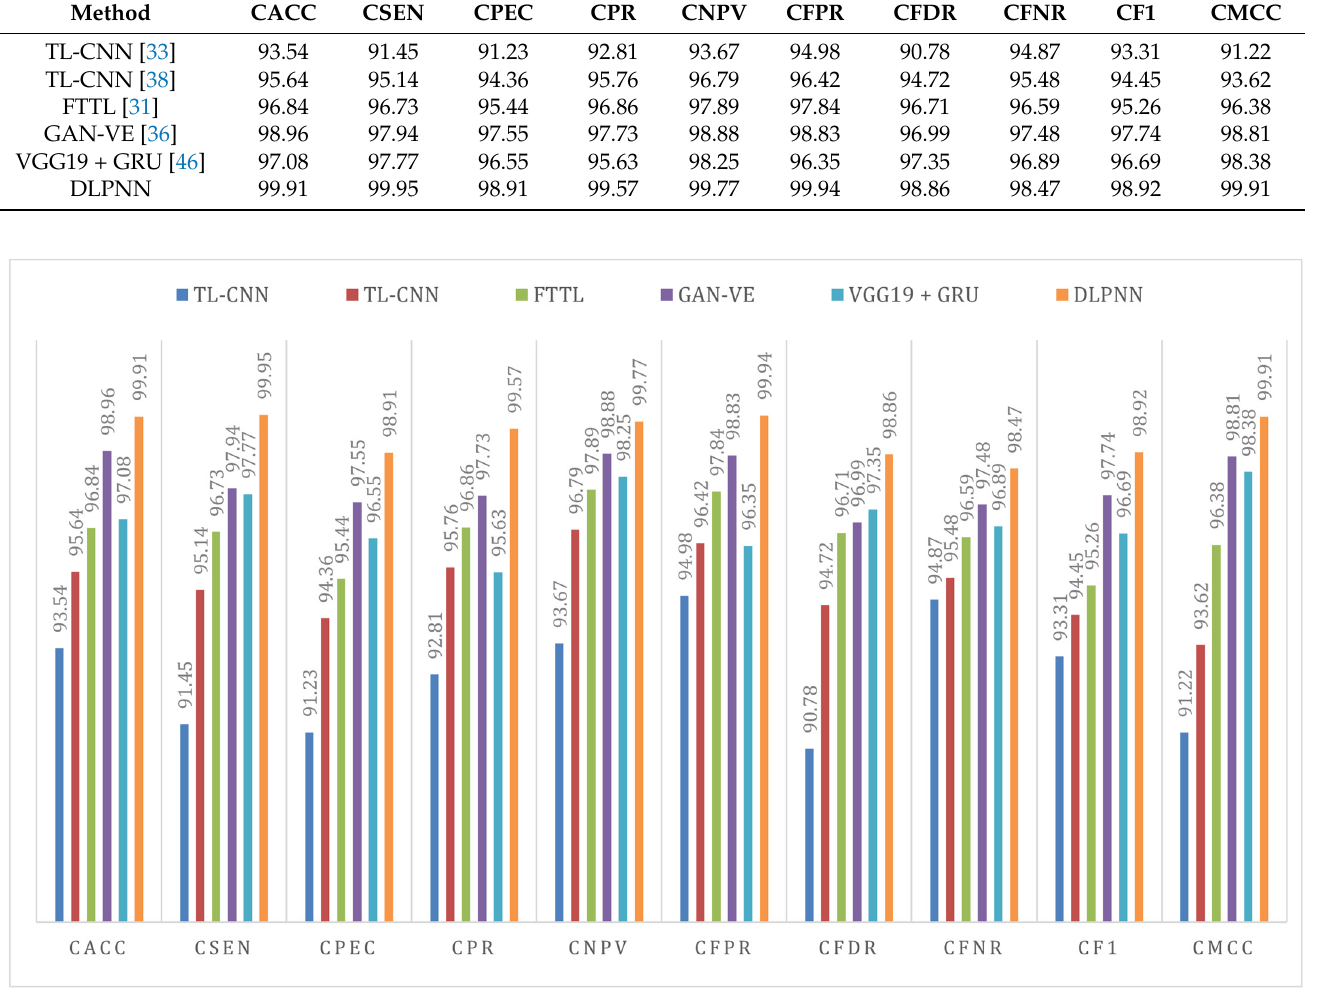
Figure 13. Graphical representation of classification performance in percentage (TL-CNN [33], TL- CNN [38], FTTL [31], GAN-VE [36], VGG19 + GRU [46]).